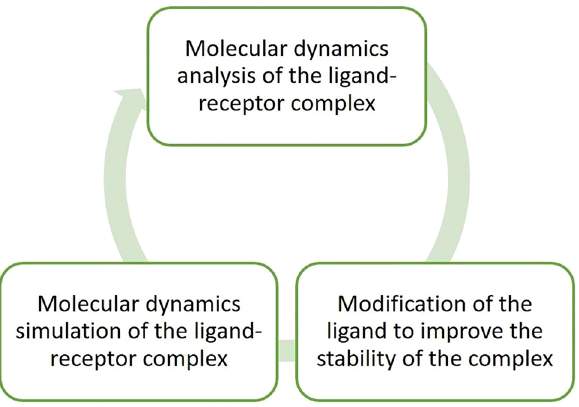
Figure 1. The flow chart of the iterative development process of